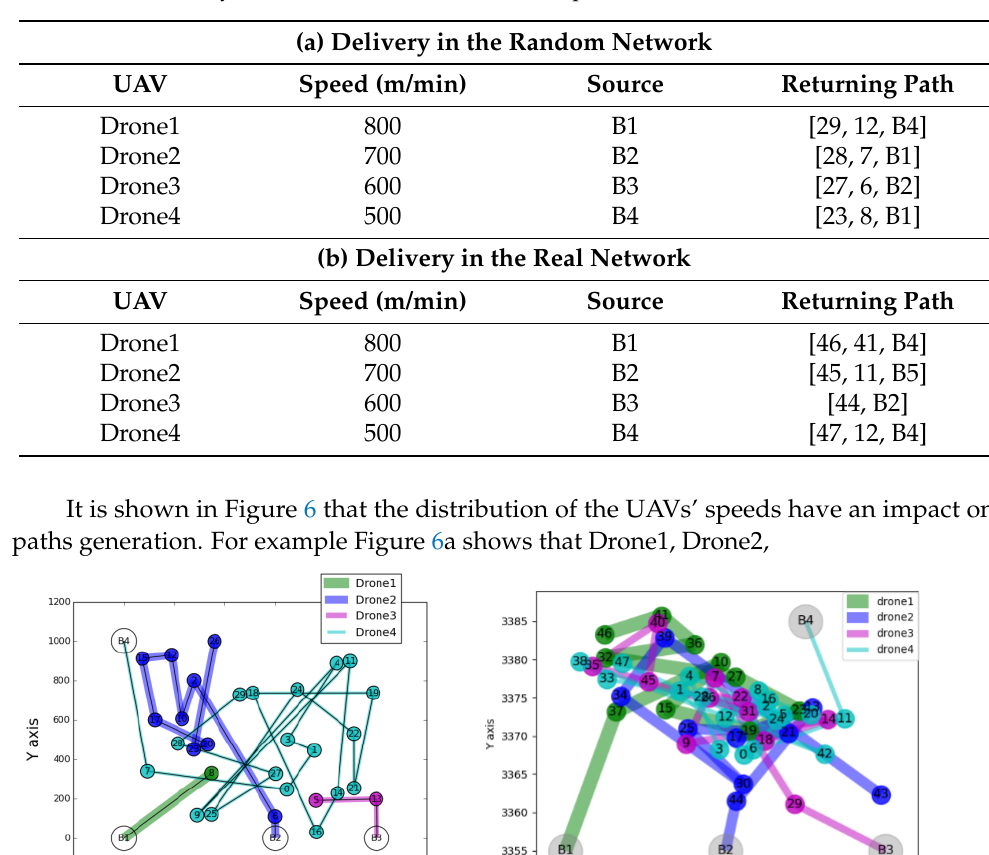
Table 3. Data delivery when all drones have a different speed.